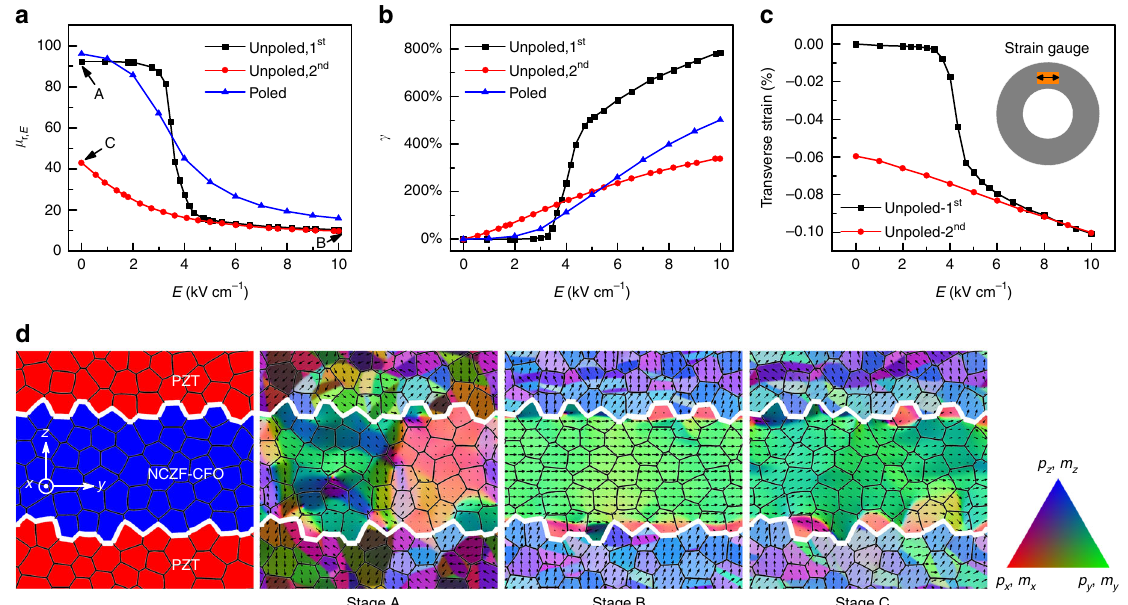
Fig. 6 Effect of internal bias stress on the tunability of VTI. a Experimentally measured magnetic permeability μ r under different electric fi elds E for VTIs with initial unpoled piezoelectric layer and initial poled piezoelectric layer. Black line represents the unpoled sample with electric fi eld increased from 0 to 10 kV cm − 1 , red line represents the unpoled sample with electric fi eld decreased from 10 to 0 kV cm − 1 , while blue line represents the poled sample with electric fi eld increased from 0 to 10 kV cm − 1 . b Corresponding tunability γ of permeability in a . c In-plane transverse strain of piezoelectric ring as a function of applied electric fi eld, measured by strain gauge. d Simulated domain structures for both ferrite and PZT layers. Stage A, stage B and stage C correspond to the three stages as marked in a . Black arrows represent polarization or magnetization distribution. Color contours the three components of polarization or